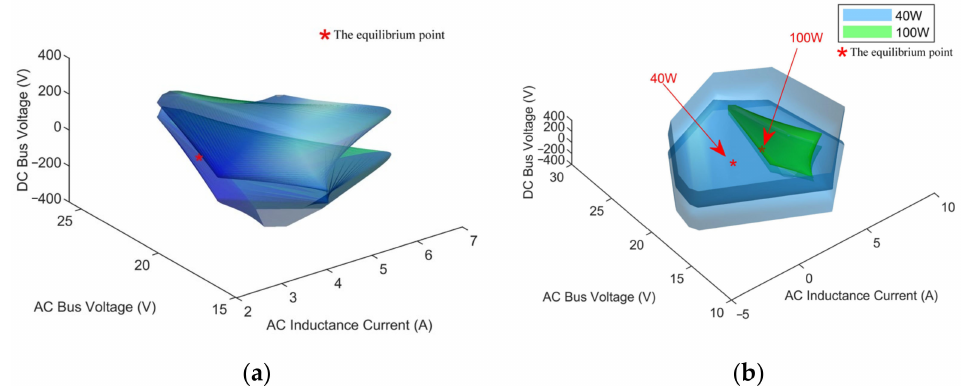
Figure 16. ( a ). The 3D RAS of microgrids with the battery in discharging mode (CPL power was 100 W).